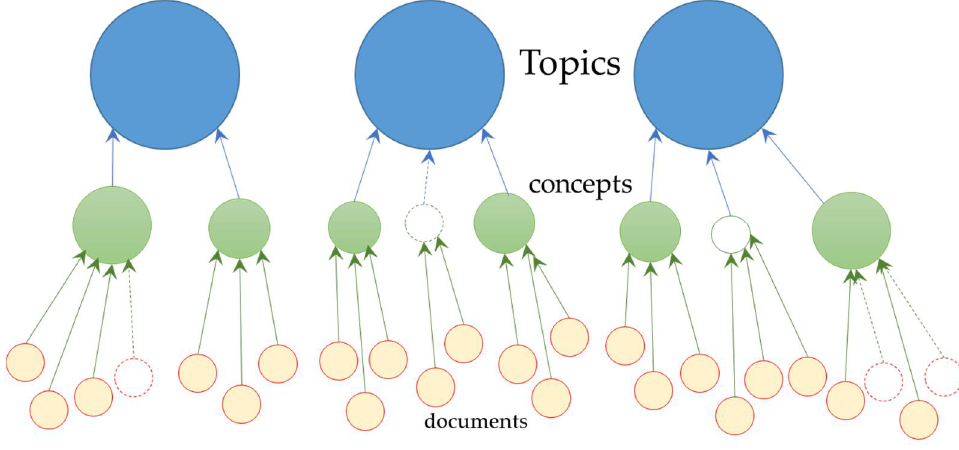
Figure 1. Schematic diagram of the Multi-stage Document Clustering (MSDC) process with HAC techniques.